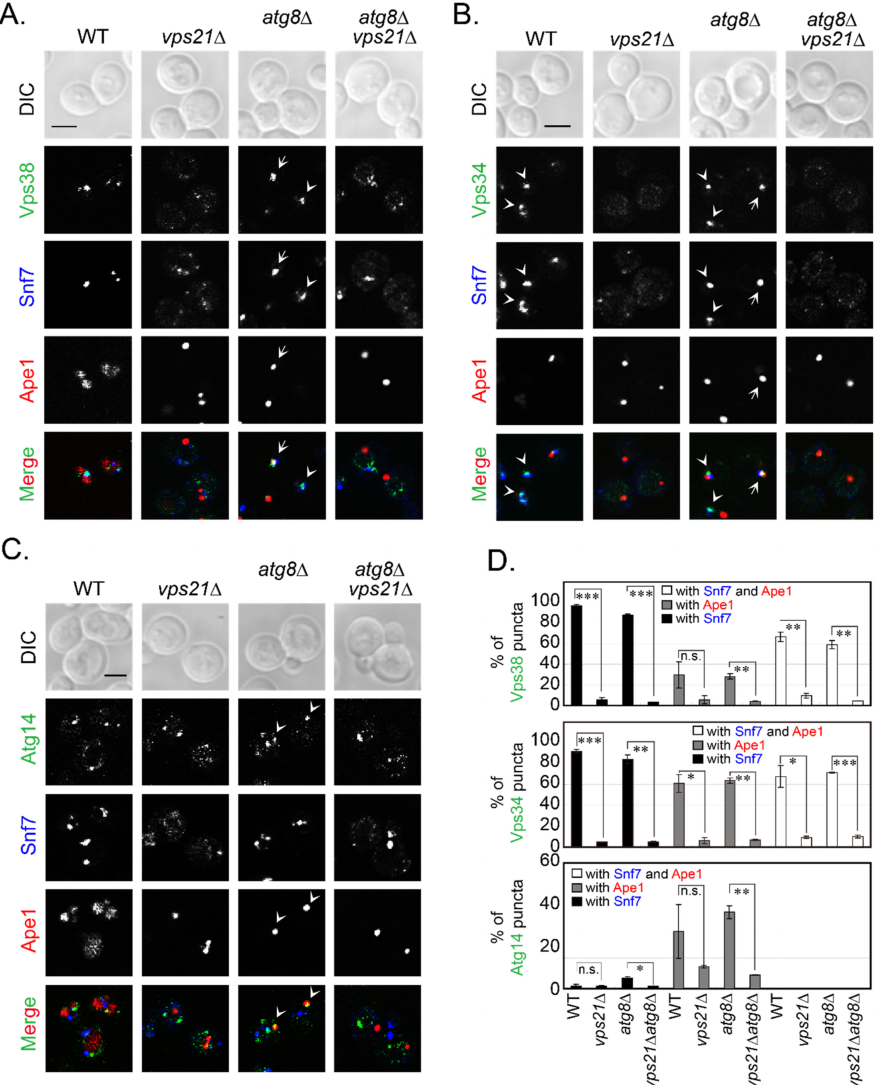
Figure 3. Localizations of PI3K complex subunits on endosomes and/or the PAS decrease in vps21 ∆ cells under nitrogen starvation. Cells were grown to mid-log phase and then switched to SD-N medium for 2 h. ( A ) Vps38-mNeonGreen, mainly localized to Snf7-2xmTagBFP2-labeled endosomes, although it also partially localized to RFP-Ape1-labeled PAS/APs and to dots positive for both Snf7-2xmTagBFP2 and RFP-Ape1. ( B ) Vps34-mNeonGreen largely localized to Snf7-2xmTagBFP2-labeled endosomes, although it also considerably localized to RFP-Ape1-labeled PAS/APs and to over half of all dots that were positive for both Snf7-2xmTagBFP2 and RFP-Ape1. ( C ) Atg14-2xmNeonGreen, partially localized to RFP-Ape1-labeled PAS/APs, and it also weakly localized to Snf7-2xmTagBFP2-labeled endosomes but did not localize to dots positive for both Snf7-2xmTagBFP2 and RFP-Ape1. In panels ( A – C ), all colocalizations were Vps21-dependent. The arrows indicate colocalization of the PI3K complex subunit at dots positive for both Snf7-2xmTagBFP2 and RFP-Ape1. The arrowheads indicate colocalization of the PI3K complex subunit at either endosomes or the PAS/APs. Scale bars, 2 µ m. ( D ) Quantification of the subunits of PI3K complexes at endosomes and/or the PAS/APs. The percentages of green puncta (Vps38, top; Vps34, middle; Atg14, bottom) at Snf7-2xmTagBFP2-labeled endosomes, RFP-Ape1-labeled PAS/APs, or both (using samples represented in panels ( A – C )) were quantified and are presented as the mean ± SD. n.s., not significant; *, p < 0.05; **, p < 0.01; ***, p <